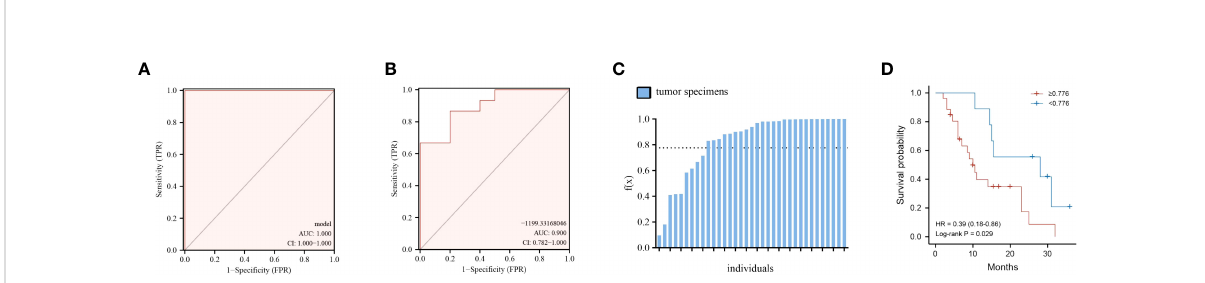
FIGURE 5 Performance of the six-metabolite panel biomarkers in the discrimination and predicting prognosis of PC. (A, B) ROC curve of metabolites panel model for prediction in discovery group (A) and validation group (B) . (C) Logistic regression values f(x) for all the patients under the discriminant models. (D) Kaplan – Meier curves of overall survival for all patients using the discriminant model. Red line, patients with f(x) ≥ 0.776; blue line, patients with f(x) <